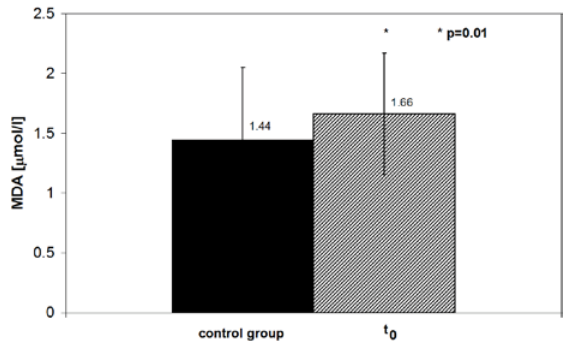
, 5 min after PCI; t 5